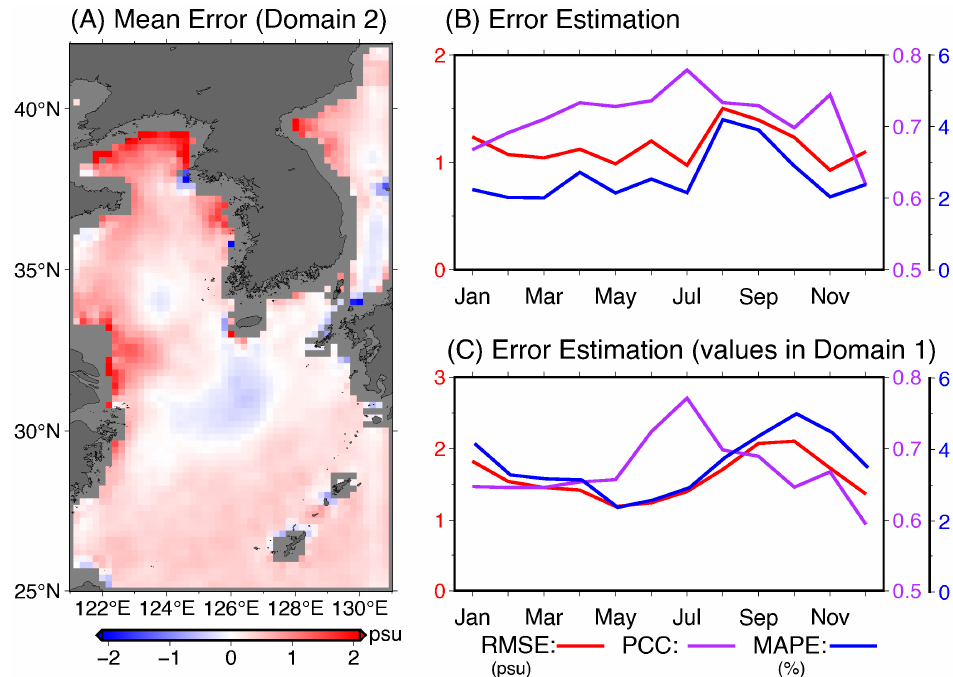
Figure 6. ( A ) Annual mean error of the predicted SSSs in 2021 over Domain 2 and ( B ) the monthly variations of the error estimations. For ease of comparison, error estimations using data from Domain 1 are also plotted in panel ( C ).